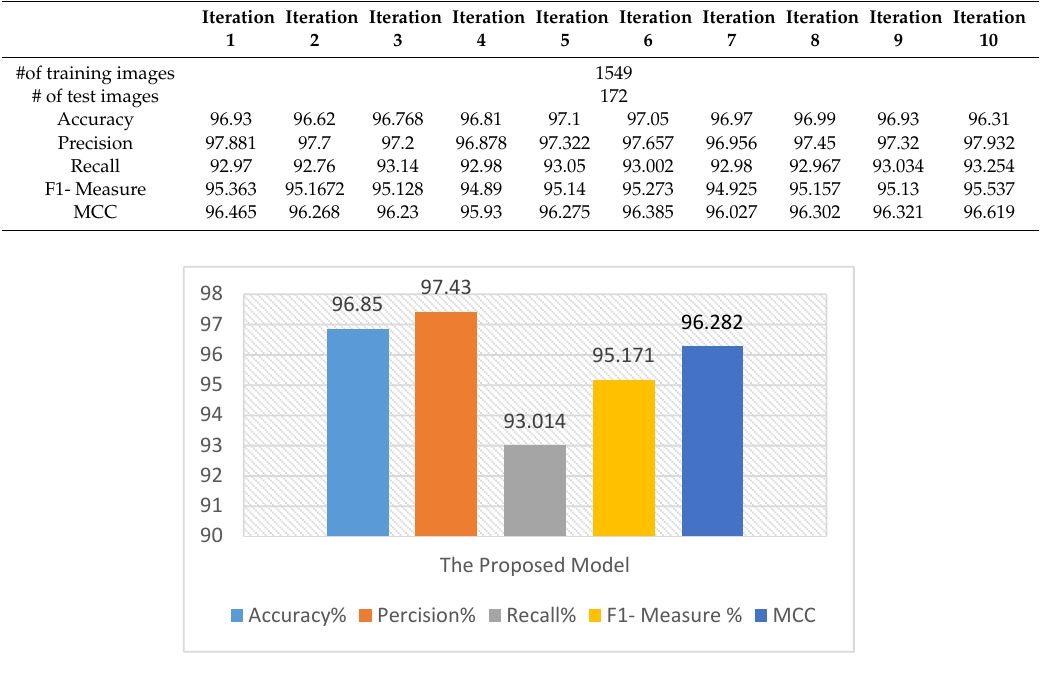
Table 3. The detailed results of 10-fold cross-validation on CASIA V1.0 using the proposed model.